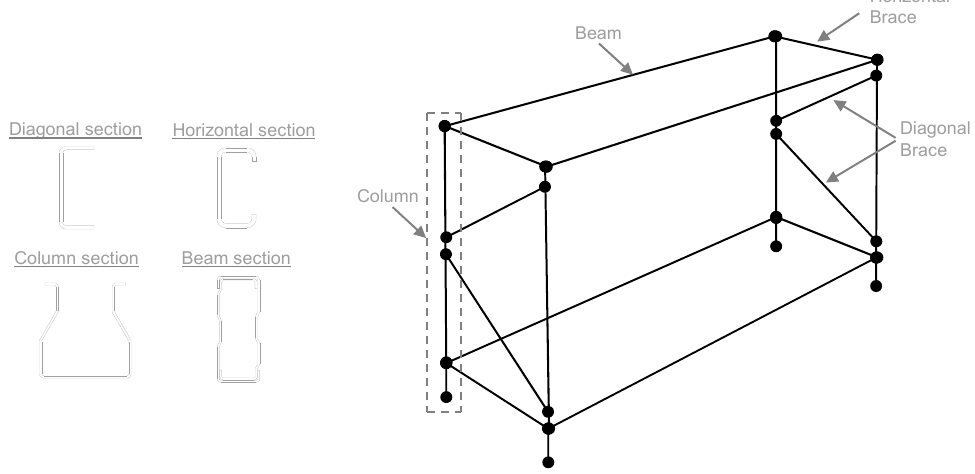
Figure 1. Basic structuring of each level of the racks analyzed. Table 1. Properties of the cross-sections of the structural elements of the racks.